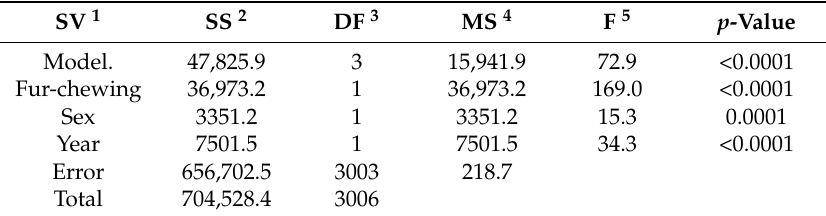
Table 3. Genetic variance estimates of the father ( σ 2 a ), genetic variance of the mother ( σ 2 m ), phenotypic variance ( σ 2 p ) and heritability ( h 2 ) with their standard errors (S.E.) for fur-chewing in chinchillas. Variable σ 2 a ± S . E . σ 2 m ± S . E . σ 2 p ± S . E . h 2 ± S . E . Fur-chewing 0.044 ± 0.017 0.042 ± 0.022 1.087 ± 0.024 0.160 ±